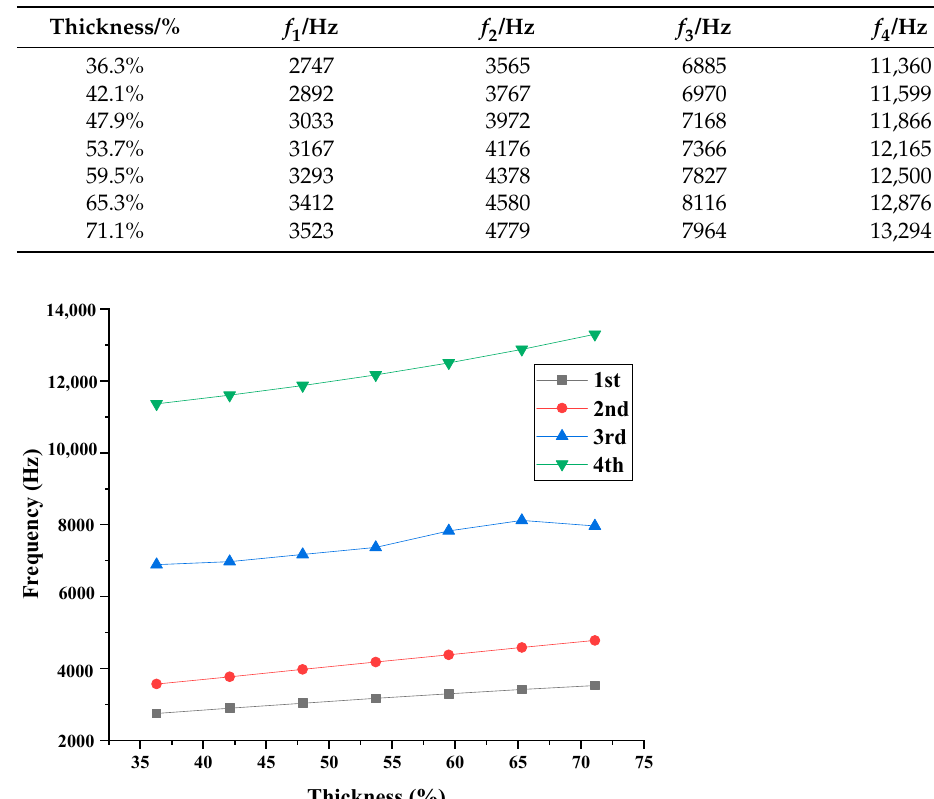
Table 9. The change of 3rd ND TWR speed at different thickness of spoke plate.